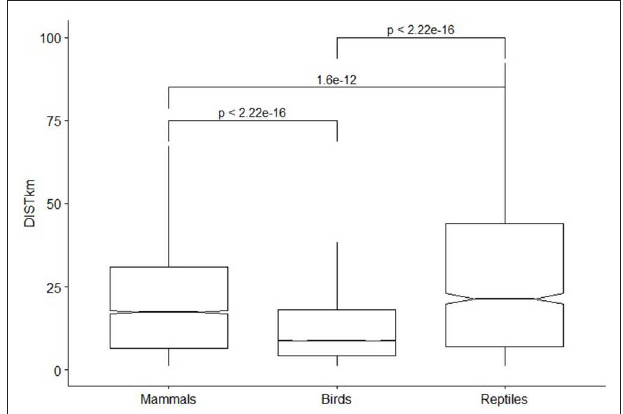
FIGURE 2 | Mean distances and quartiles of catch of mammals, birds and reptiles groups during the whole study. Probability of Student paired tests is indicated for each comparison. Box plots are figured without